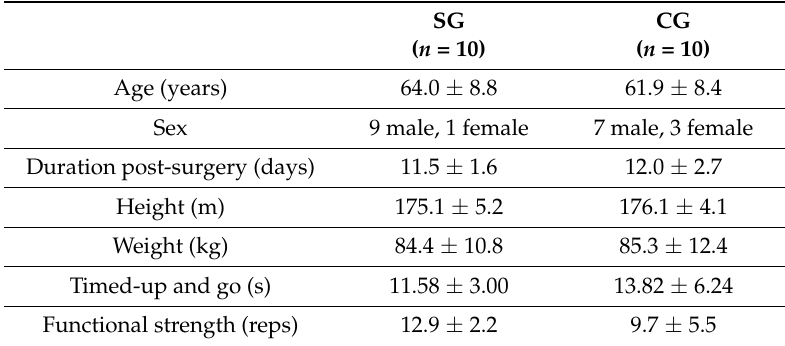
Table 1. Characteristics of the sonification (SG) and control group (CG). Values are means ± standard